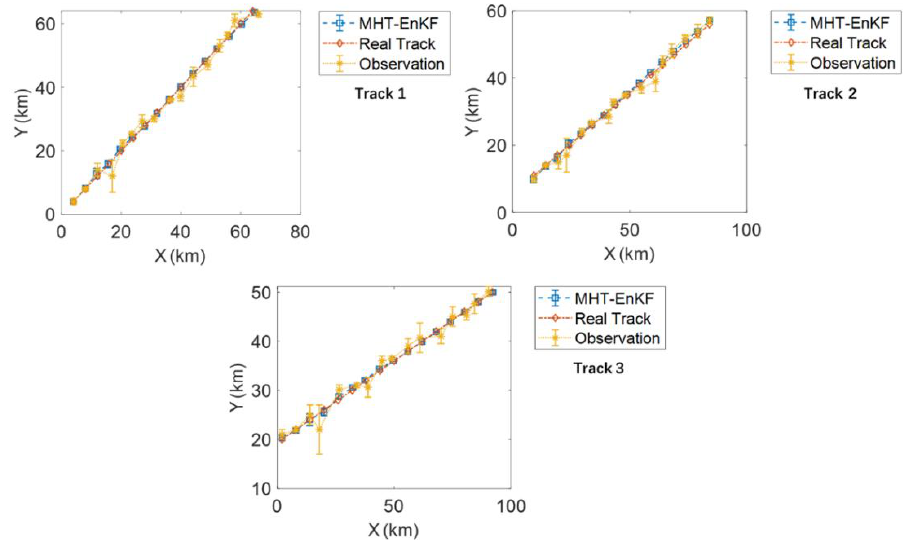
Figure 12. The comparison between the actual tracks, the corresponding observation points and the MHT-EnKF tracking results of Track 1, Track 2 and Track 3.